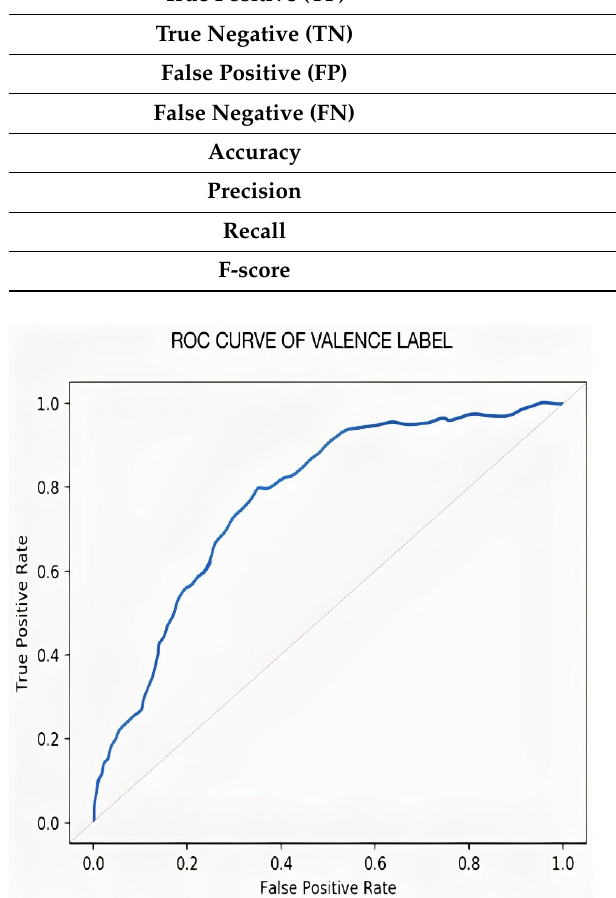
Figure 13. ROC curve of valence label.